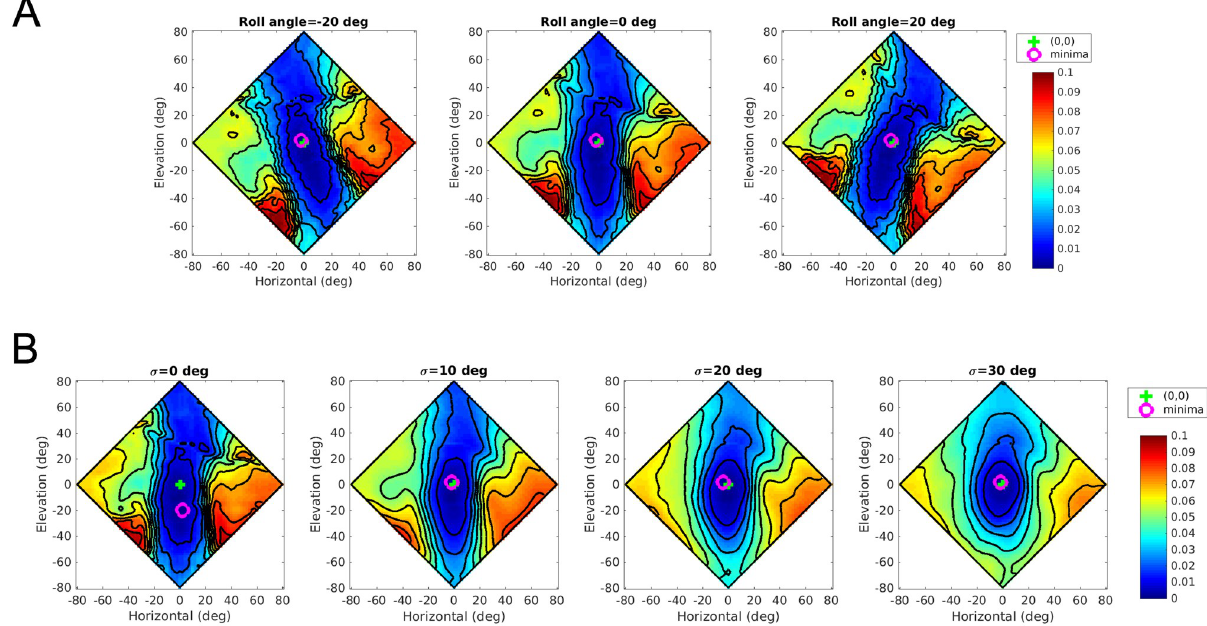
Fig 6. The reconstruction error surfaces. The reconstruction error as a function of horizontal and elevation coordinates. The symbols “+” and “o” indicate the (0,0) coordinates and the minima of the error surface respectively. (A) The reconstruction error for the GASSOM ( σ = 10) at the head roll angles of -20, 0, and 20 deg. (B) The reconstruction error surface at different head roll standard deviations.